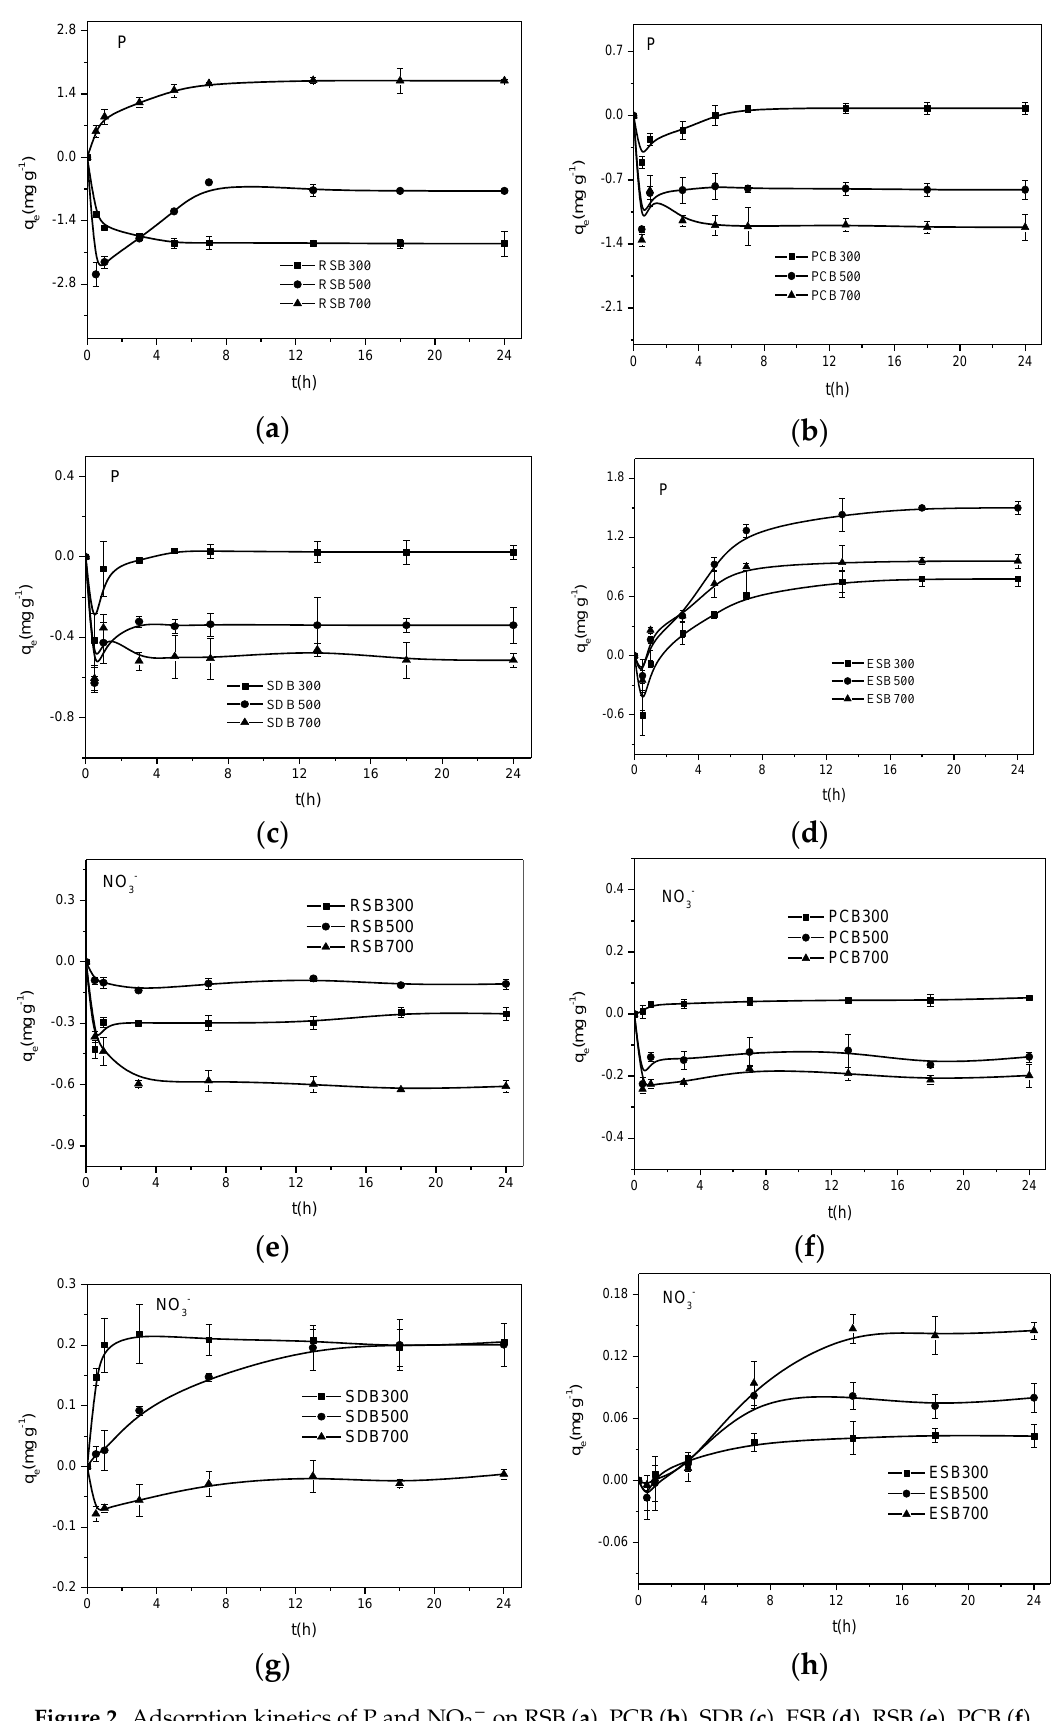
Figure 2. Adsorption kinetics of P and NO 3− on RSB ( a ), PCB( b ), SDB ( c ), ESB(d), RSB ( e ), PCB( f ), SDB ( g ), and ESB( h ), respectively. Data are means ± SD of n = 3.